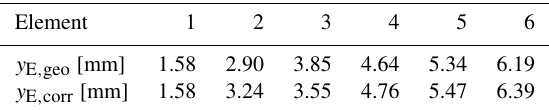
Table 2. Comparison of time differences between the two echo parts gained from sound field simulation ( t sim ) and determined with a geometric model via Fermat’s principle ( t geo ).